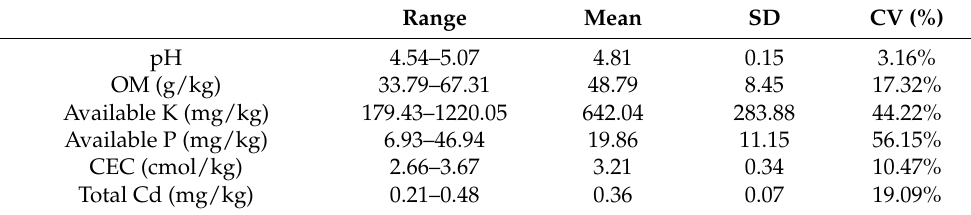
Table 1. Total Cd concentration and selected properties of paddy soil ( n = 16).